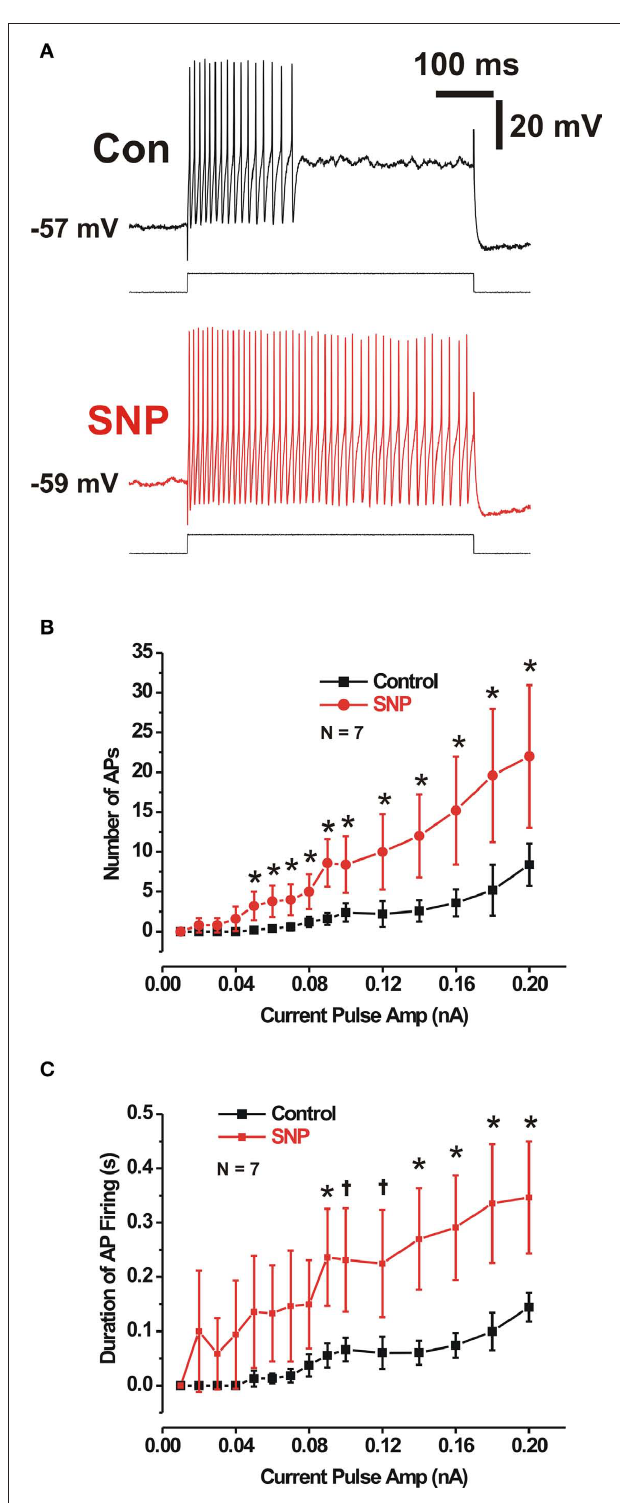
FIgurE 5 | Sodium nitroprusside increased the excitability of submucosal neurons displaying IPSPs. (A) Action potentials (APs) evoked by a 500-ms duration depolarizing current pulse in control (black), and in SNP (red). Quantitative data over a range of current amplitudes for AP number and firing duration (B,C) . * P < 0.05 (two-tailed t